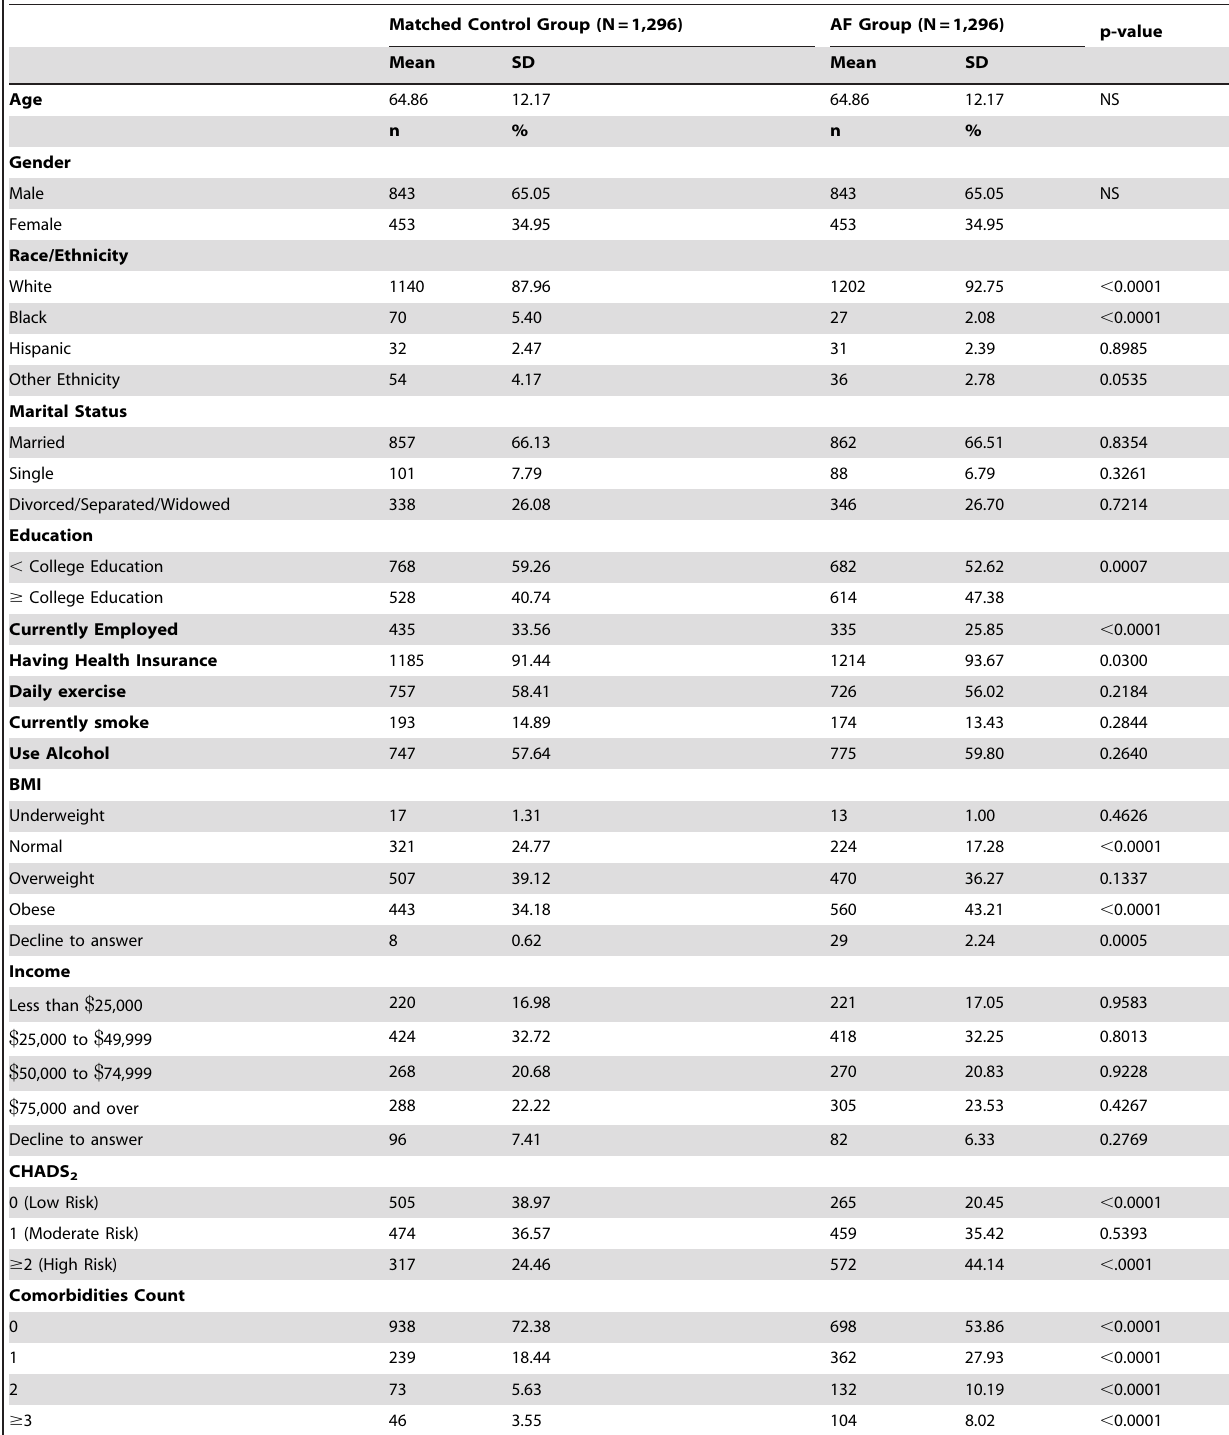
Matched Control Group (N=1,296) AF Group